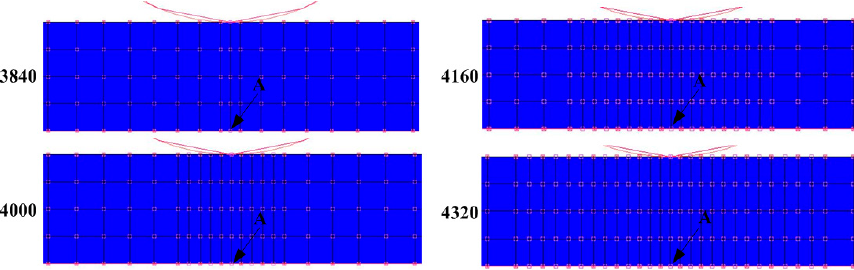
Figure 9. Different division schemes of mesh refinement.